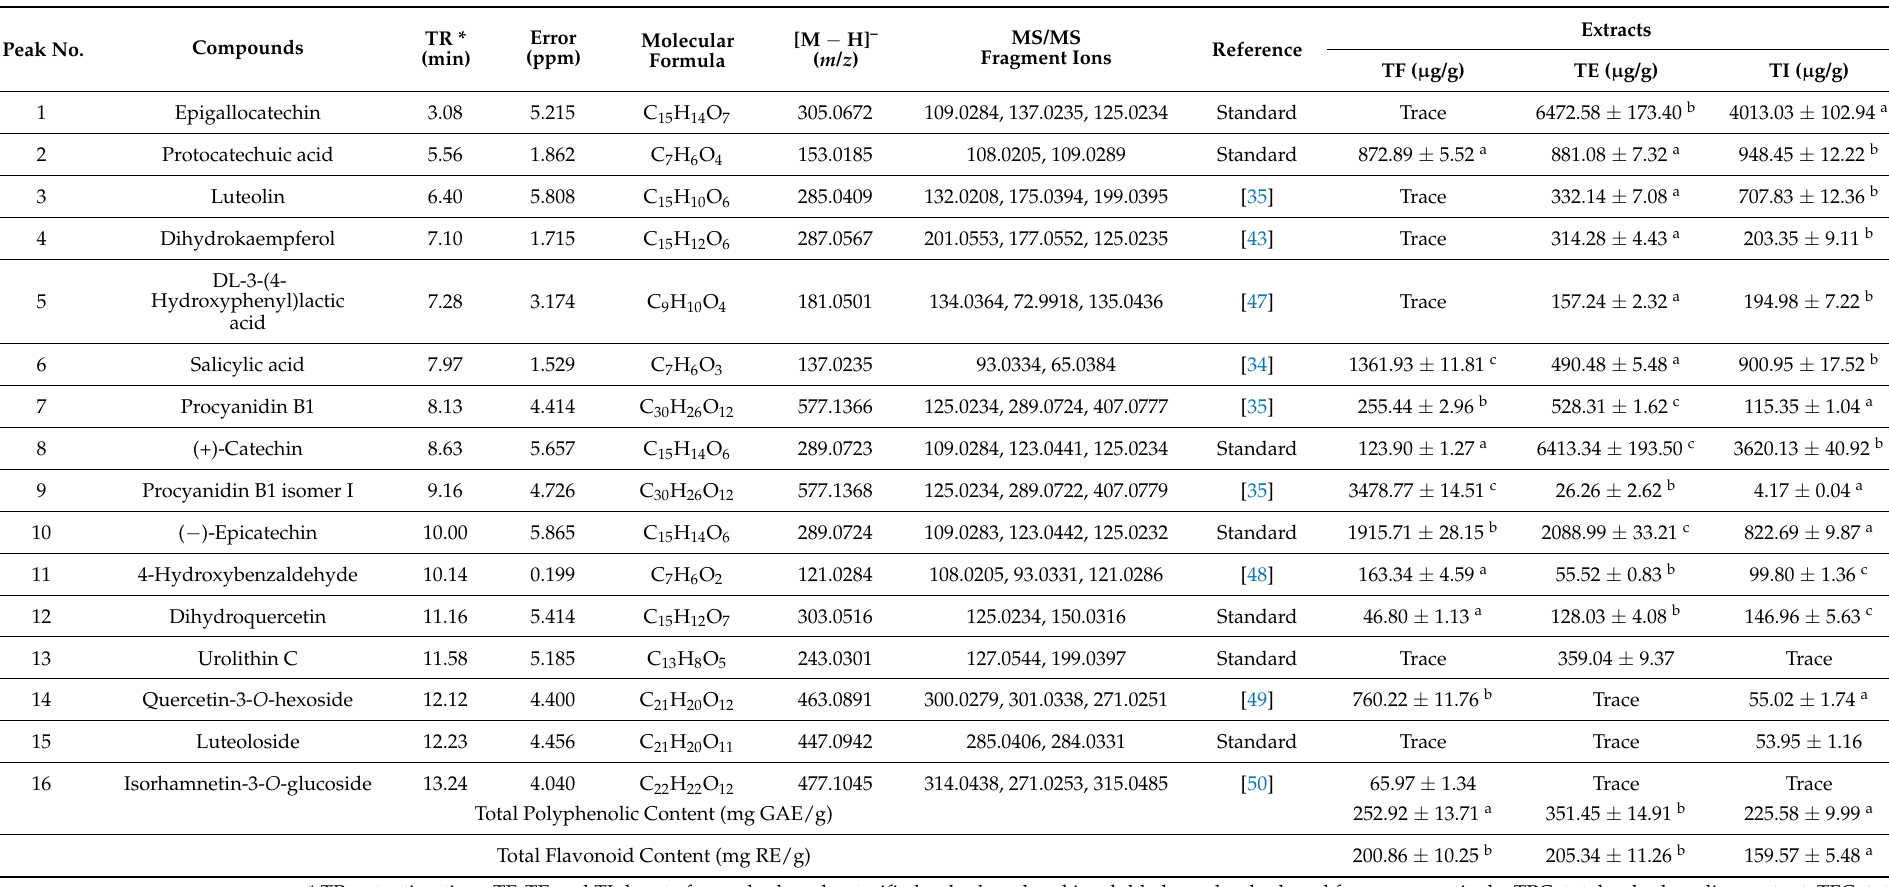
Table 1. The identified chemical constituents, total polyphenols and total flavonoids in the TF, TE and TI extracts from the seed shell of Prinsepia utilis Royle. Peak